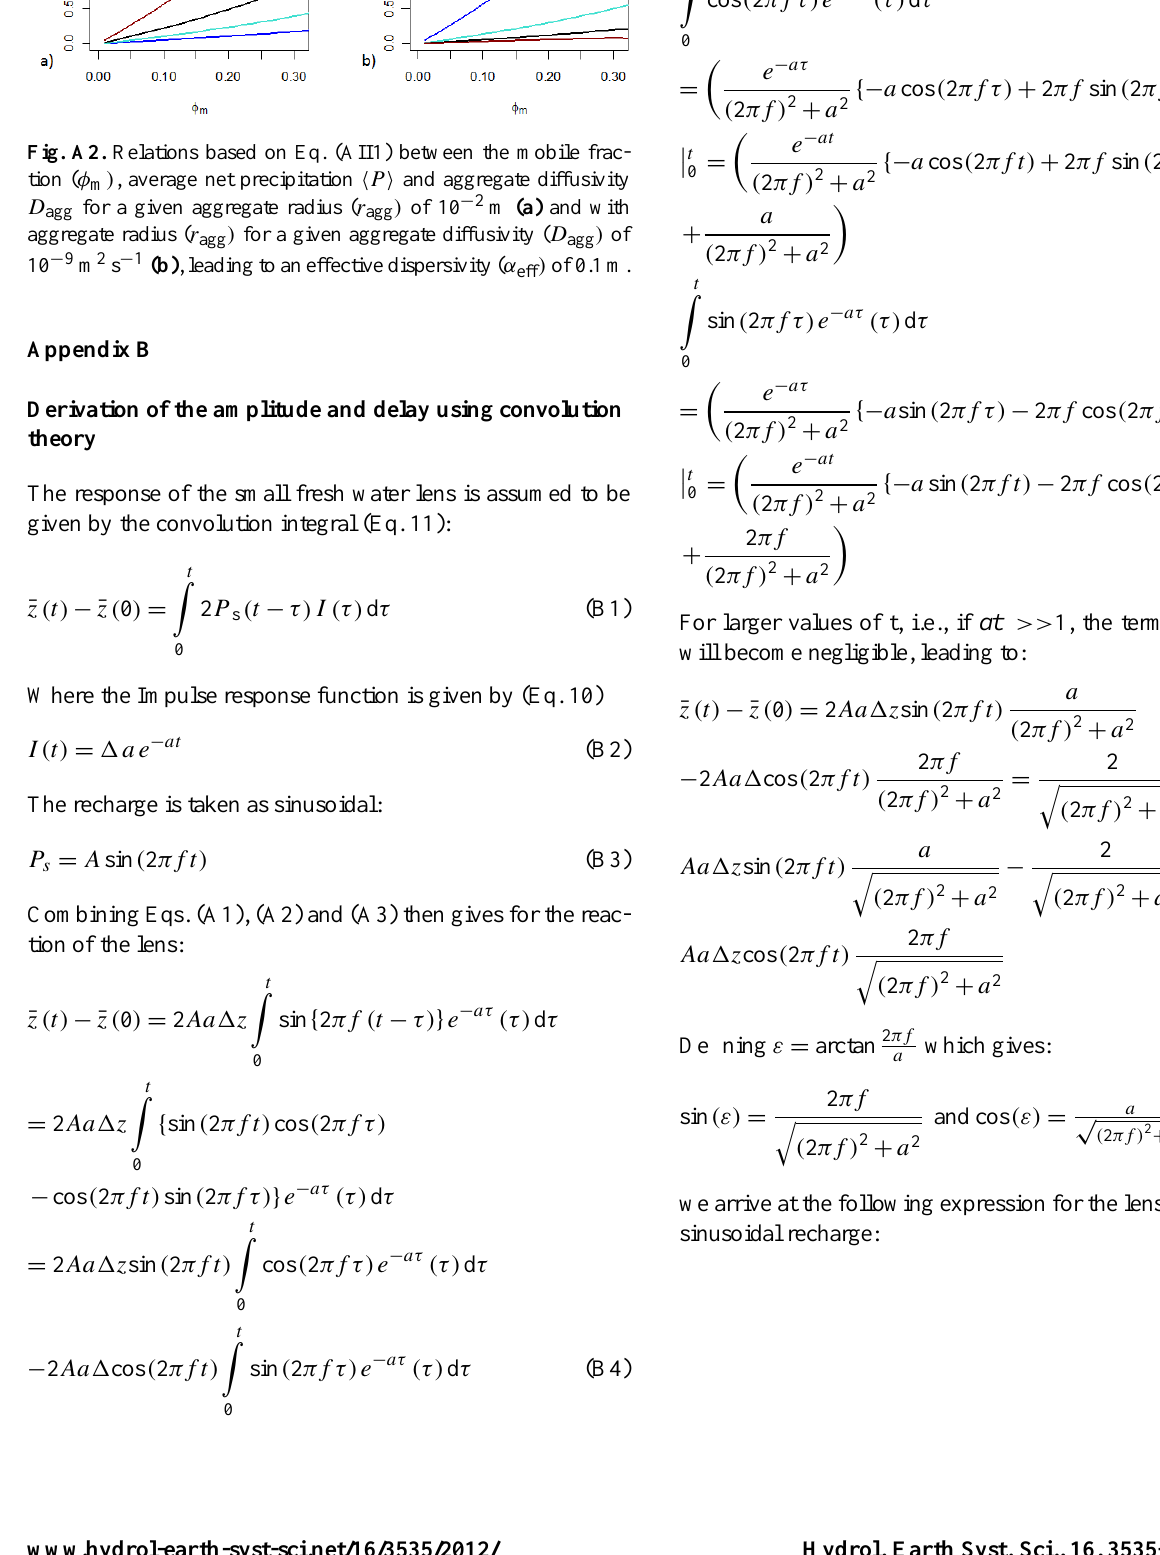
tion ( φ m ) , average net precipitation h P i and aggregate diffusivity